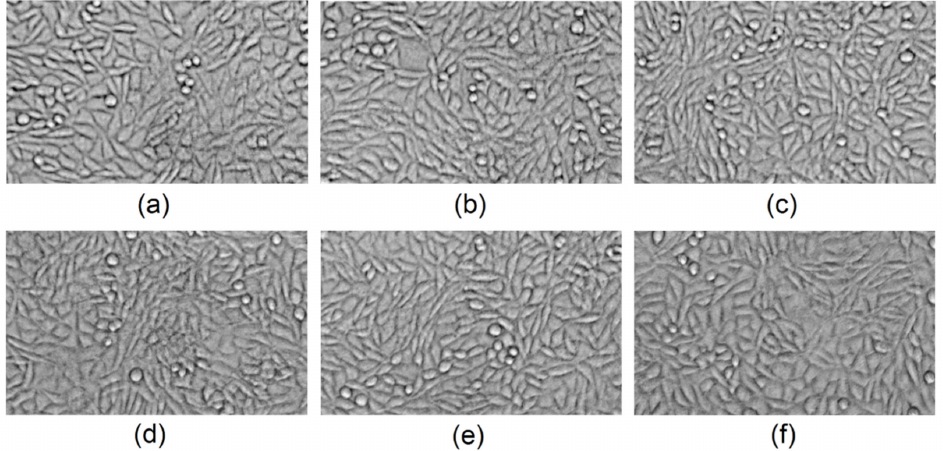
Figure 19. Fibroblasts’ morphology study: ( a ) control; ( b ) raw chitosan; ( c ) Gel-1; ( d ) Gel-2; ( e ) Gel-3; ( f )